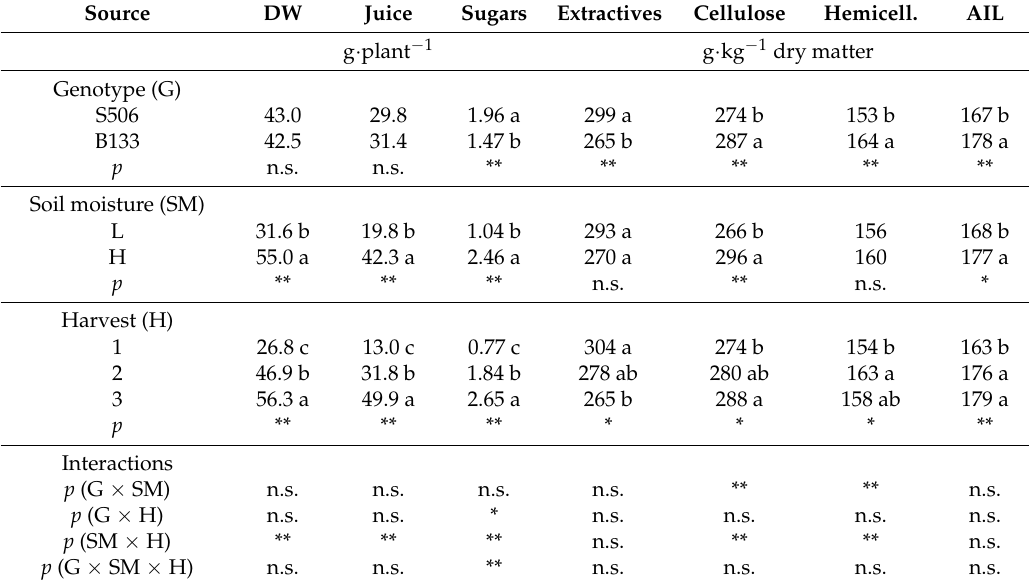
Table 1. Sorghum dry weight, juice and sugar content, and chemical composition of residual bagasse. Source DW Juice Sugars Extractives Cellulose